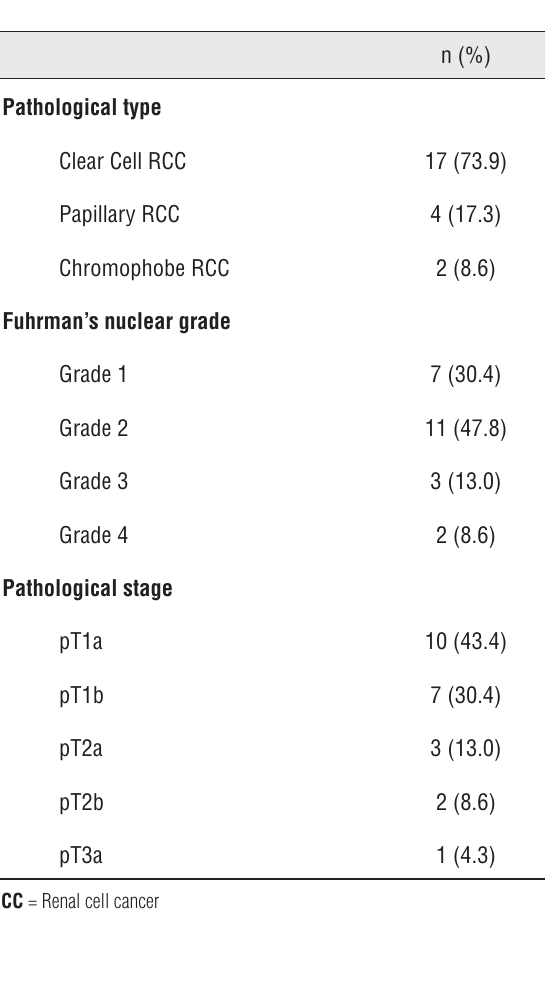
figure 1 - ROc curve analysis of renal cancer patient fNDc5/ irisin and cEA values.